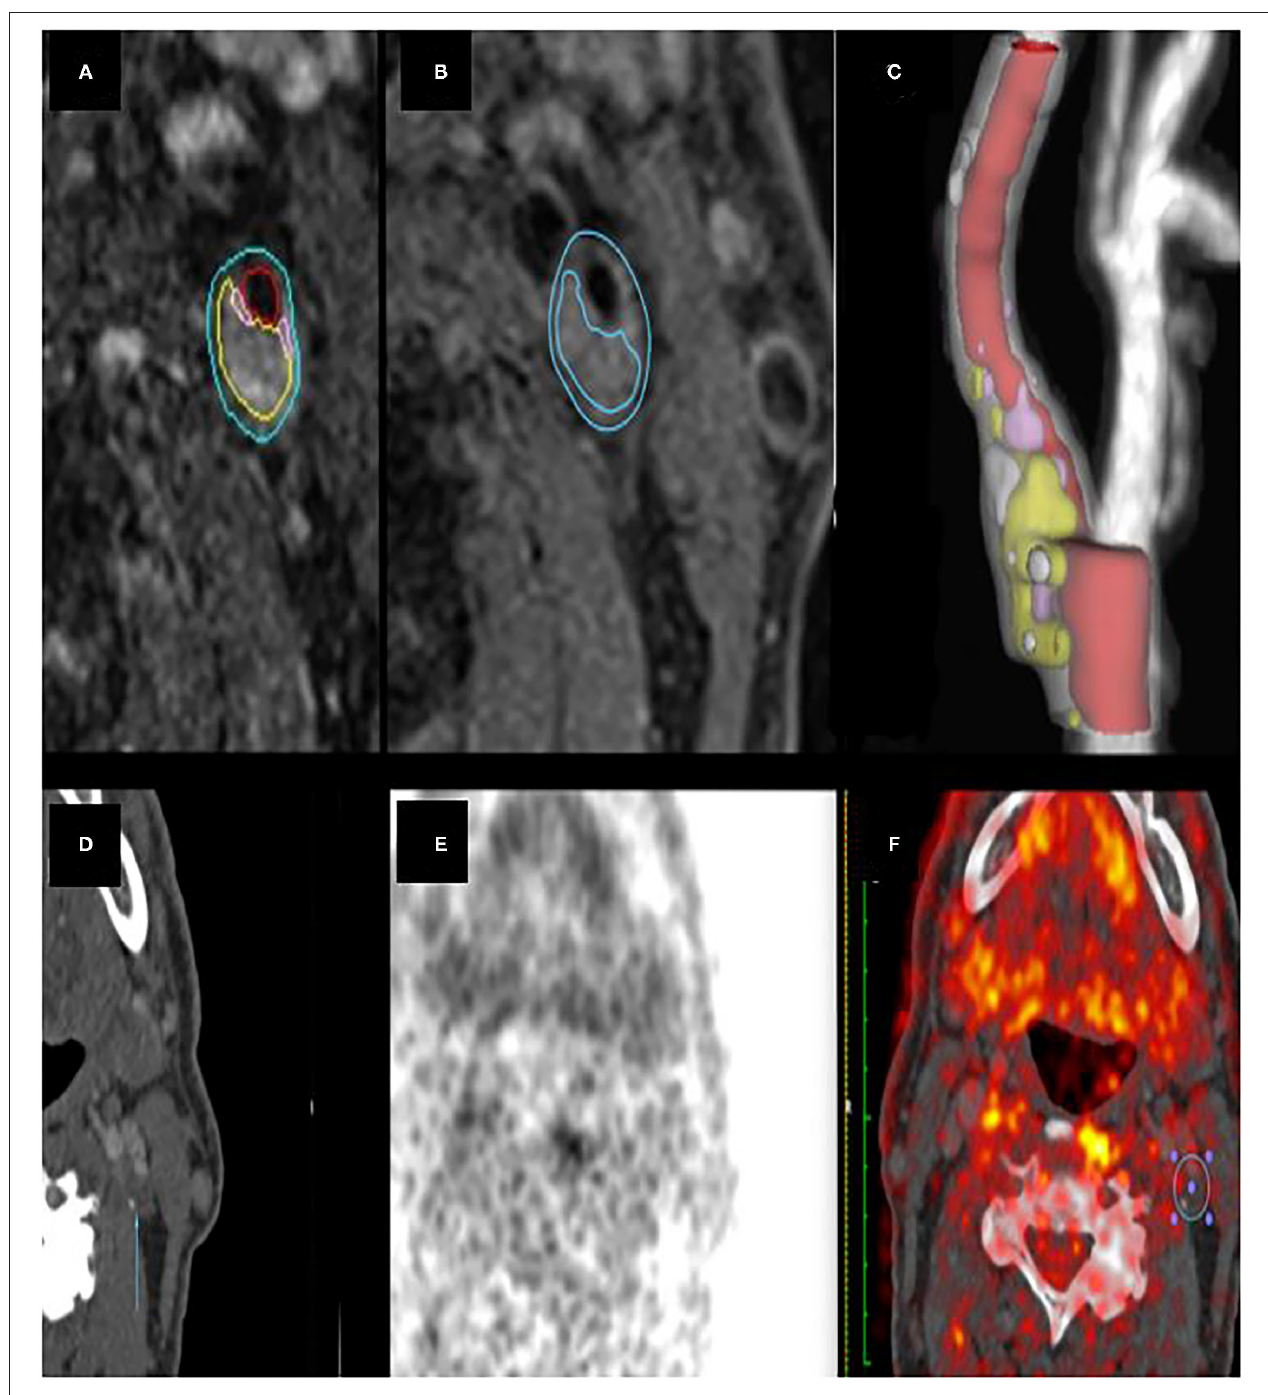
FIGURE 1 | (A) carotid MRI semi-automatic segmentation of lumen and vessel wall. (B) semi-automatic plaque characterisation of an LRNC area. (C) ICA plaque 3D Volume Rendering. (D–F) CT and PET images of the same plaque area. The ROI (F) shows where SUV max was measured.